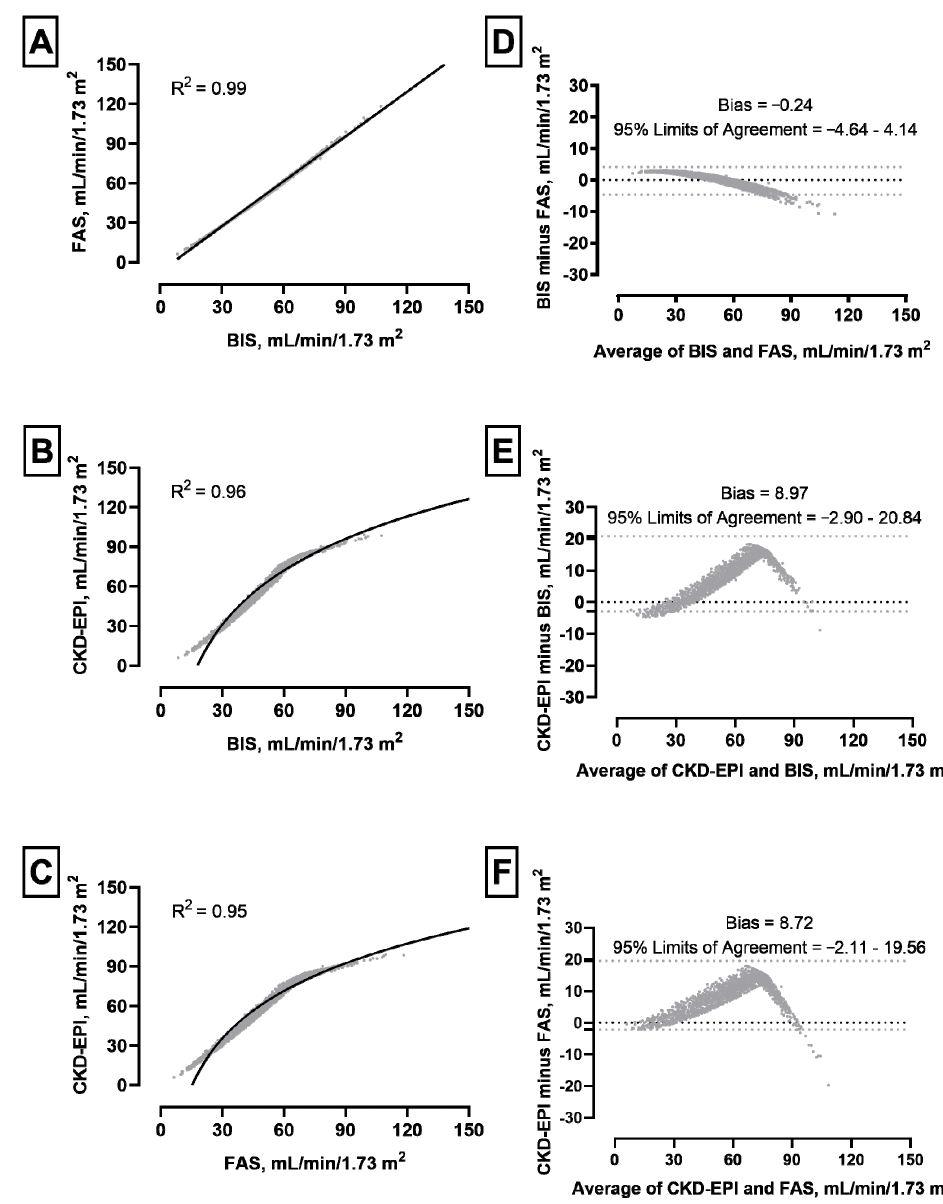
Figure 1. Crude correlations among eGFR equations (panels A , B , C ) and Bland–Altman analysis (Panels D , E , F ). Figure 1 shows the correlation of GFR values obtained when applying di ff erent equations for eGFR calculation. When testing CKD-EPI values towards the dynamic for BIS and FAS equations in the SCOPE cohort (Panels E , F ), a relevant bias of 8.97 mL / min / 1.73 m 2 for the BIS equation and 8.72 mL / min / 1.73 m 2 for the FAS equation was detected, while the bias was much lower ( − 0.24 mL / min / 1.73 m 2 ). Negative values may be explained by the methodology chosen to plot the distribution of values.